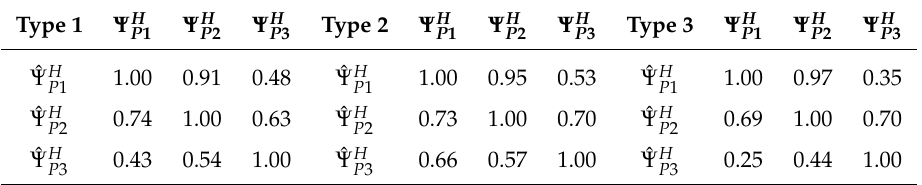
Table 1. Cross-correlation tables of the estimated signals ( ˆ Ψ H ) against measured signals ( Ψ H ) from each pavement section (P1 to P3) under the first simulation case for each type of truck: